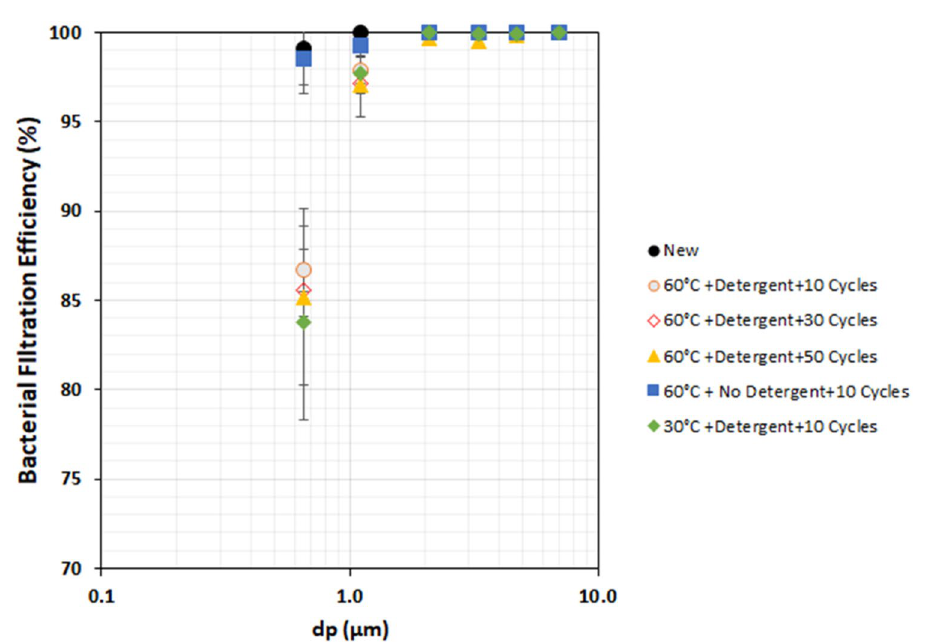
Figure 8. Influence of different washing conditions on the Spectral Bacterial Filtration Efficiency (%) of the medical face mask Average values (N = 5) ±